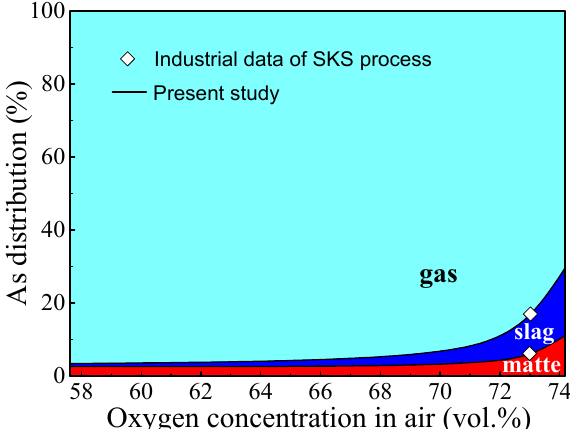
Figure 10. Effects of oxygen concentrations on arsenic distribution in SKS process.